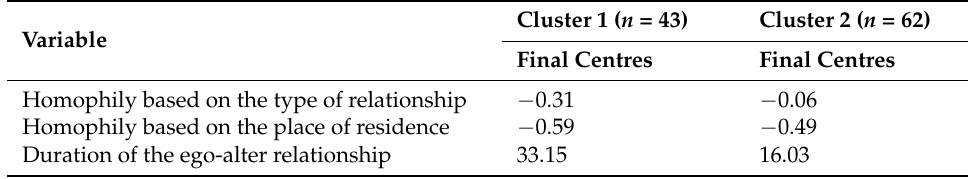
Table 2. Clusters and final cluster centres of structural and compositional indicators of personal